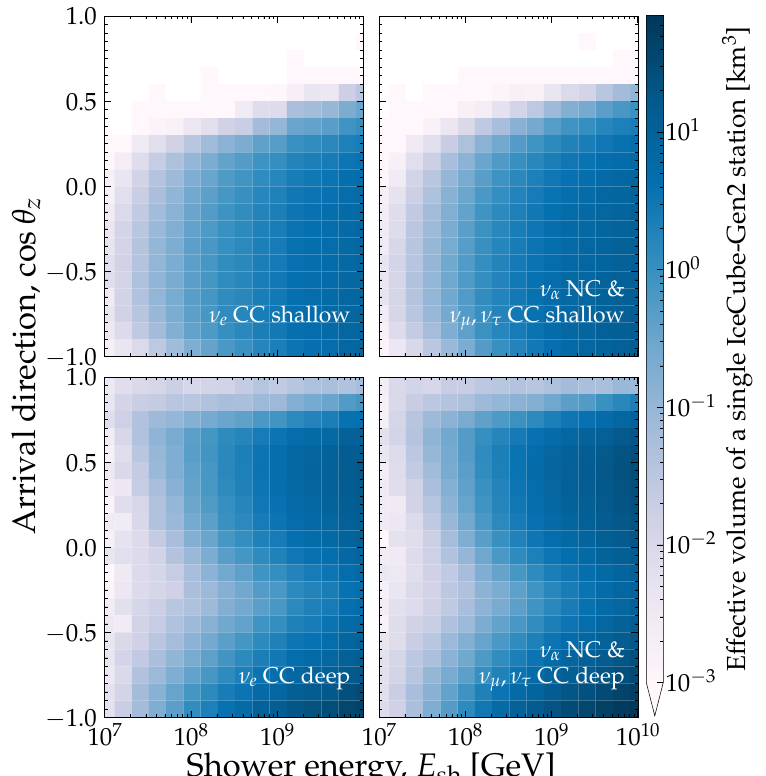
Figure 12 . Effective volume of a single detector component of the IceCube-Gen2 radio array, simulated using NuRadioMC [80]. The effective volume does not include the effects of neutrino propagation inside the Earth; its directional dependence is due only to the station geometry and to the radio propagation in the Antarctic ice. The directional dependence resulting from neutrino propagation through the Earth is computed separately on the neutrino flux; see section 5. Top row: volume for a single shallow detector component. Bottom row: volume for a single deep detector component. Left column: volume for ν CC interactions. Right column: volume for NC interactions e of all flavors and CC interactions of ν and ν . See figure 13 for the effective volume of the full µ τ array and the main text for